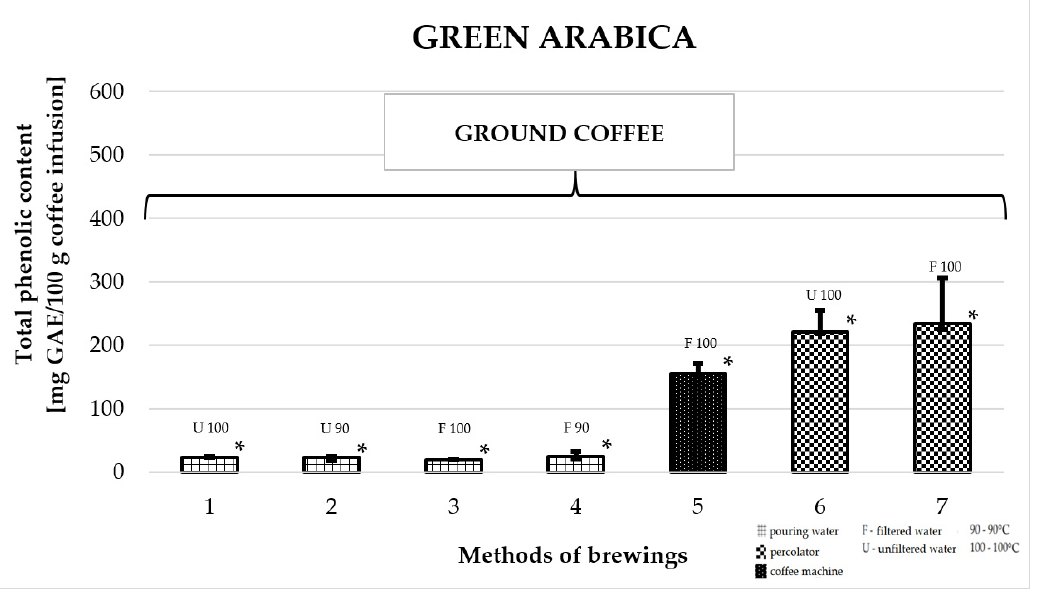
Figure 4. Median of total phenolic content as gallic acid equivalent [mg GAE/100 g of infusion] in 100% green Arabica coffee. * p 1/3,5,6,7 ; * p 2/5,6,7 ; * p 3/1,5,6,7 ; * p 4/5,6,7 ; * p 5/1,2,3,4,6,7 ; * p 6/1,2,3,4,5 ; * p 7/1,2,3,4,5 —statistically